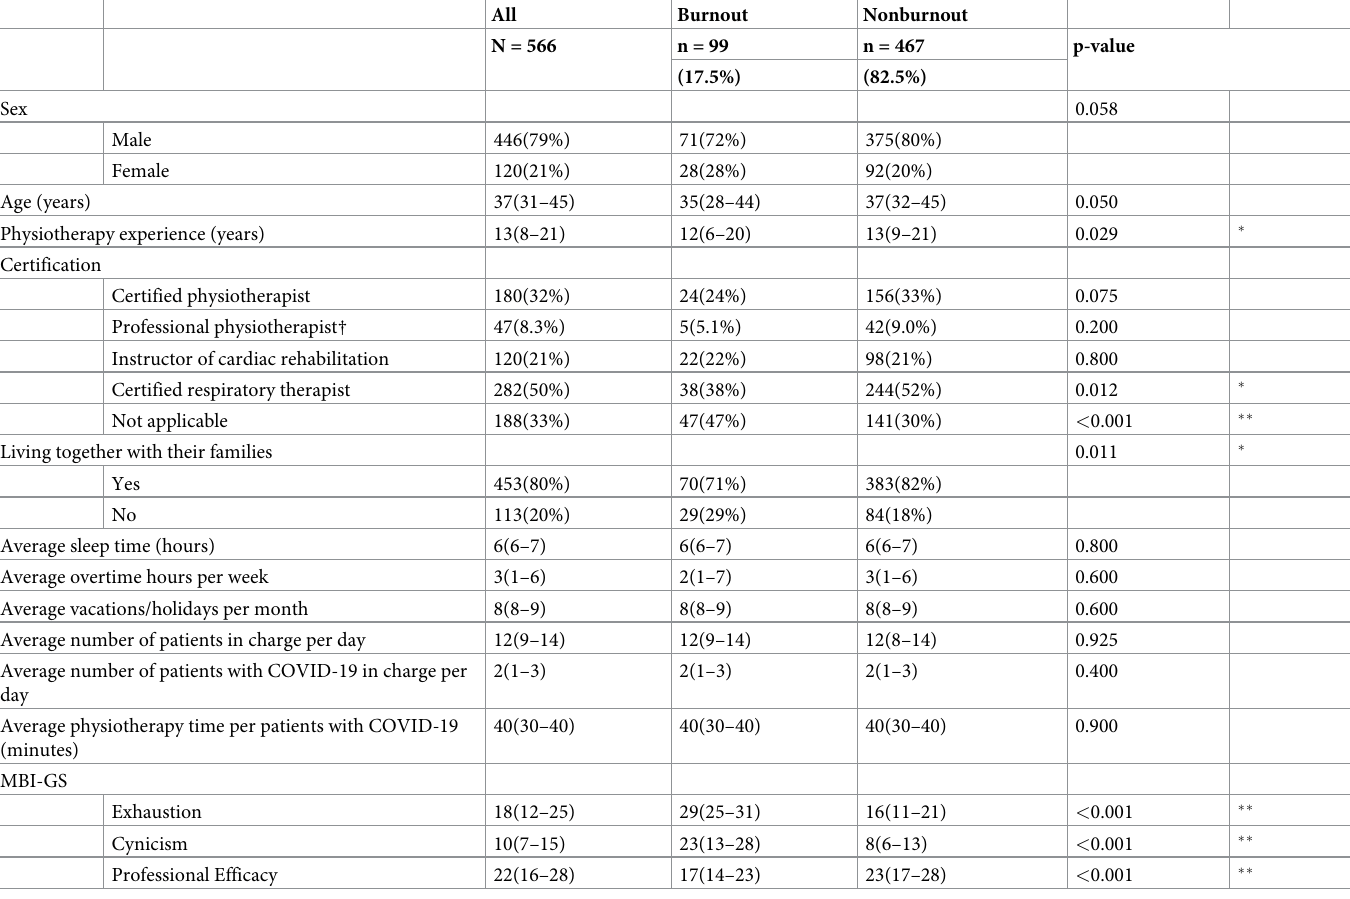
Table 1. Comparison of characteristics and the MBI-GS between the burnout and nonburnout groups.